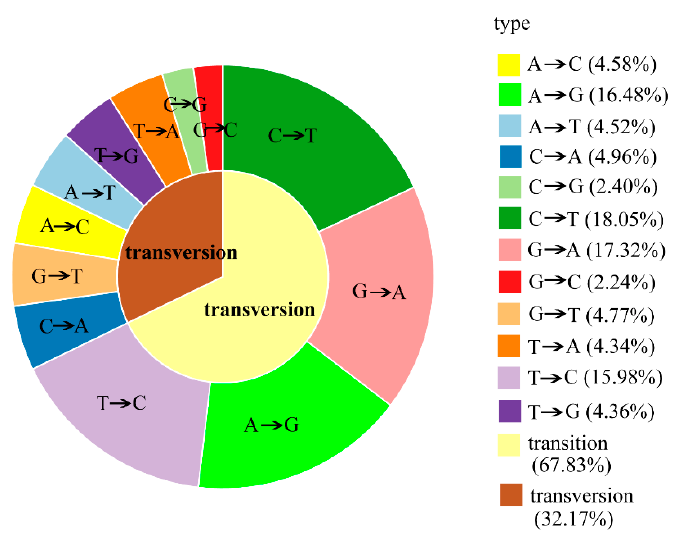
Figure 5. Ratio of SNP transitions and transversions observed in Coptis plants.